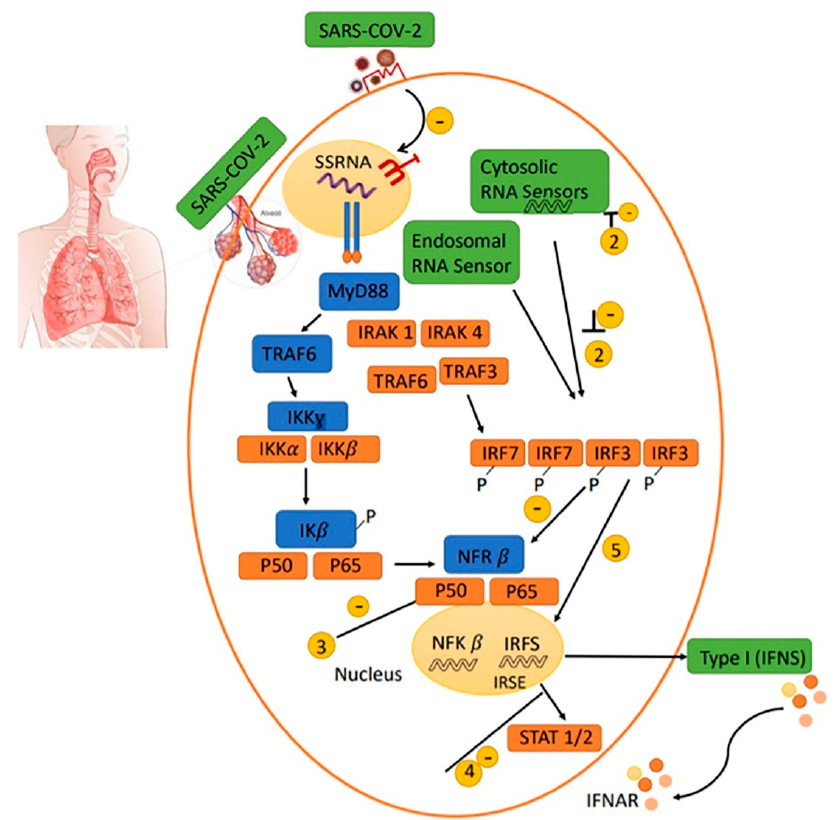
Figure 2. Proposed immune escape mechanism of SARS-CoV, MERS-CoV and possibly SARS-CoV-2. SARS-CoV-2 is attached to its receptor on the surface of target ACE2 positive cells, such as alveolar or other target cells, reducing the anti-viral IFN responses, leading to viral replication and propagation. COVID-19 may inhibit the pathways induced by TLRs3, 7, and 8, which are expressed in the endosomes. The suppression of these molecules leads to dampening of NF-kB, IRF signaling cascades, and STAT1/2 function in the nucleus, which decreases in the production of Type I IFNs responses. Delayed Type I IFNs responses may trigger immune exhaustion and the invasion of neutrophils and monocytes/macrophages into the infected cell, which may lead to cytokine storms and Th2 type responses resulting in poor